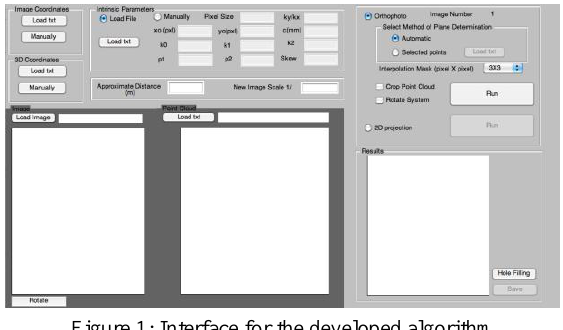
Figure 1: Interface for the developed algorithm